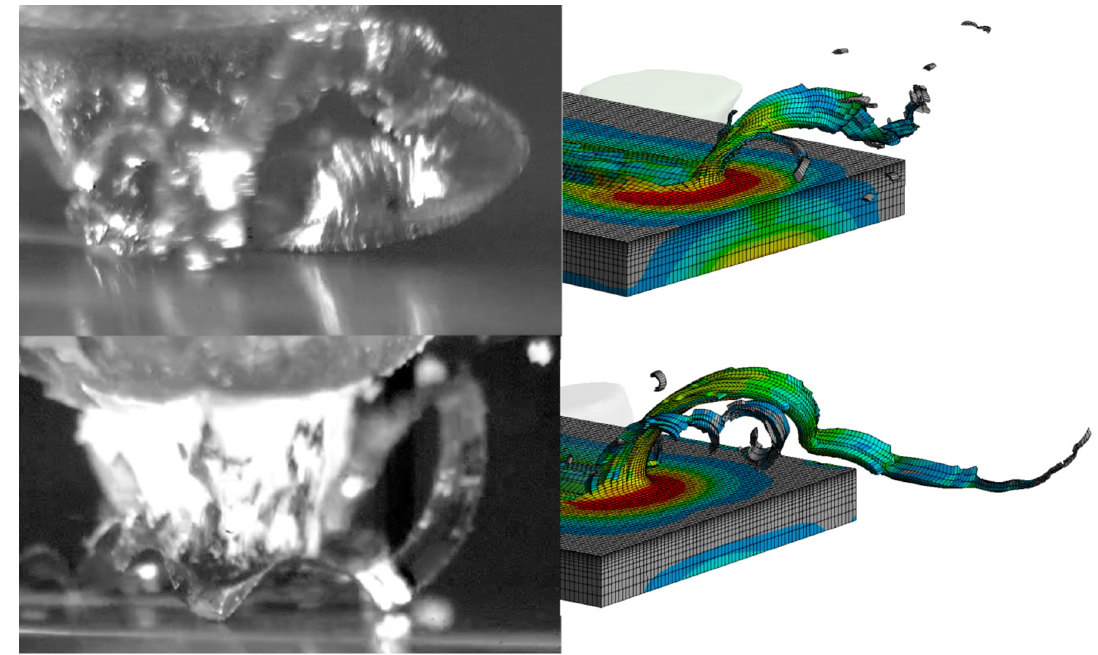
Figure 9. View of the chip formation in the cutting process with the ( a ) ZS1 grain and ( b ) ZS2